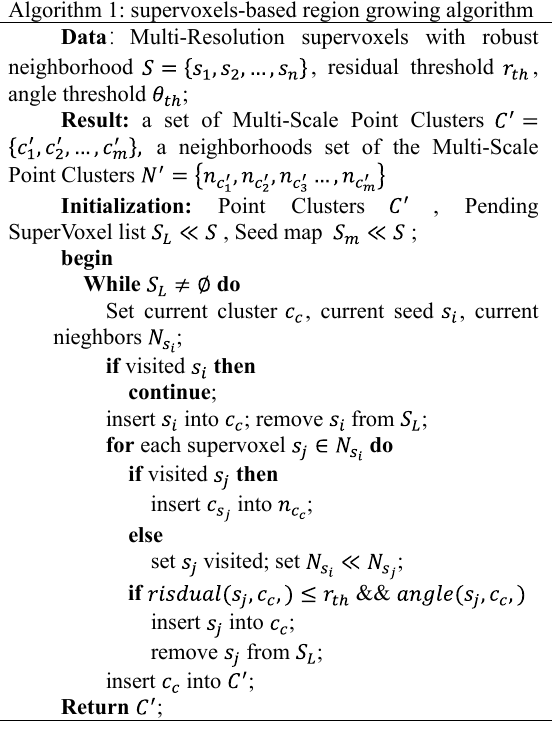
Algorithm 1: supervoxels-based region growing algorithm Data ： Multi-Resolution supervoxels with